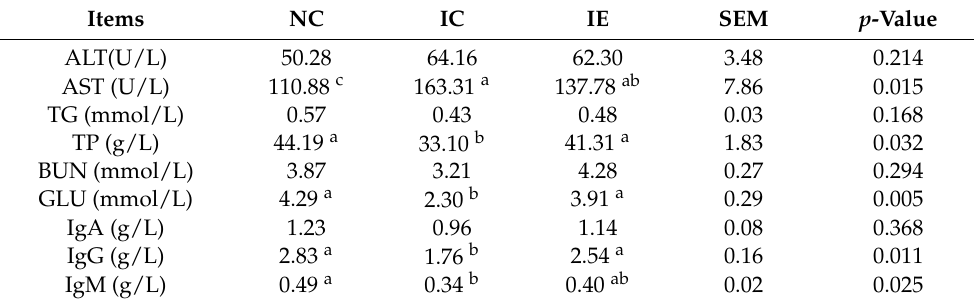
Table 4. Effects of EGF on serum biochemical profiles of piglets with